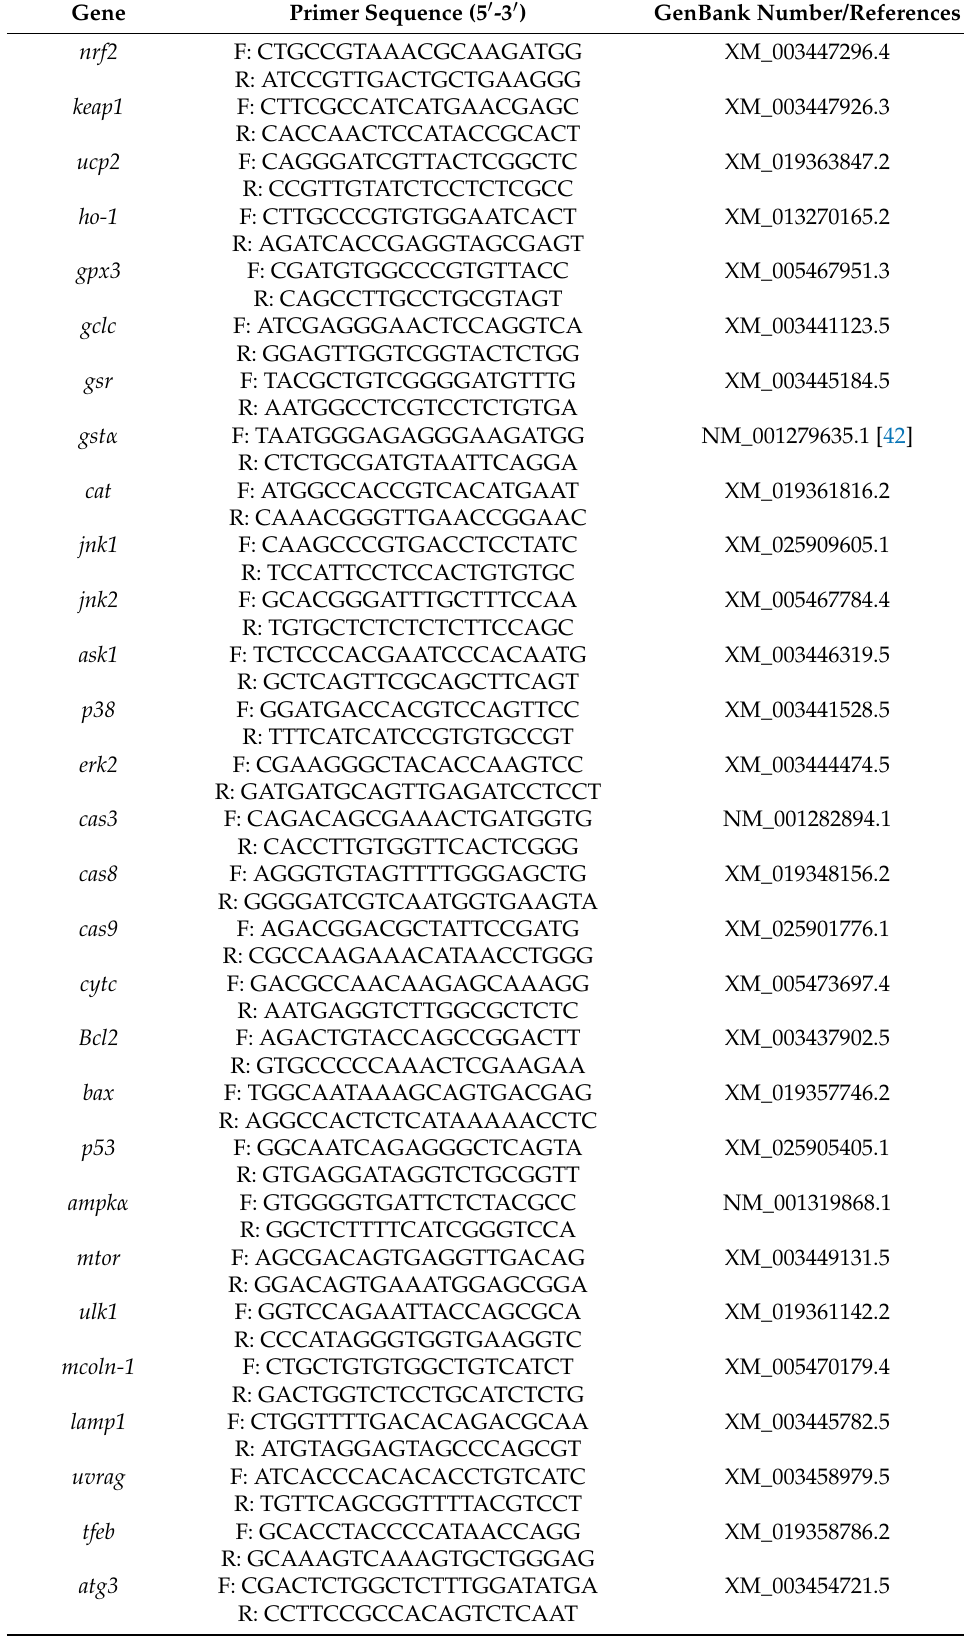
Table 2. The primer sequences used in the present